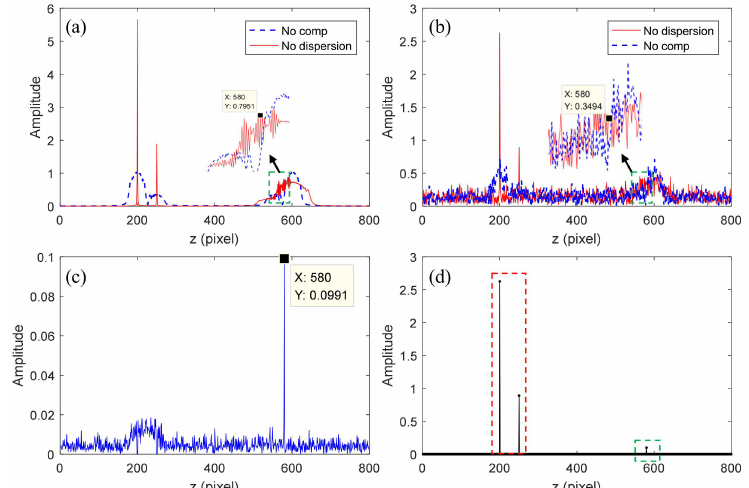
Figure 3. Simulation results of the two-step compressive dispersion encoding (TCDE) method. The results in ( a , b ) are reconstructed structural signals using 100% spectral data and 50% spectral data, respectively. The result in ( c ) is the residual signal with larger signals removed. The signals in ( d ) are the final reconstructed